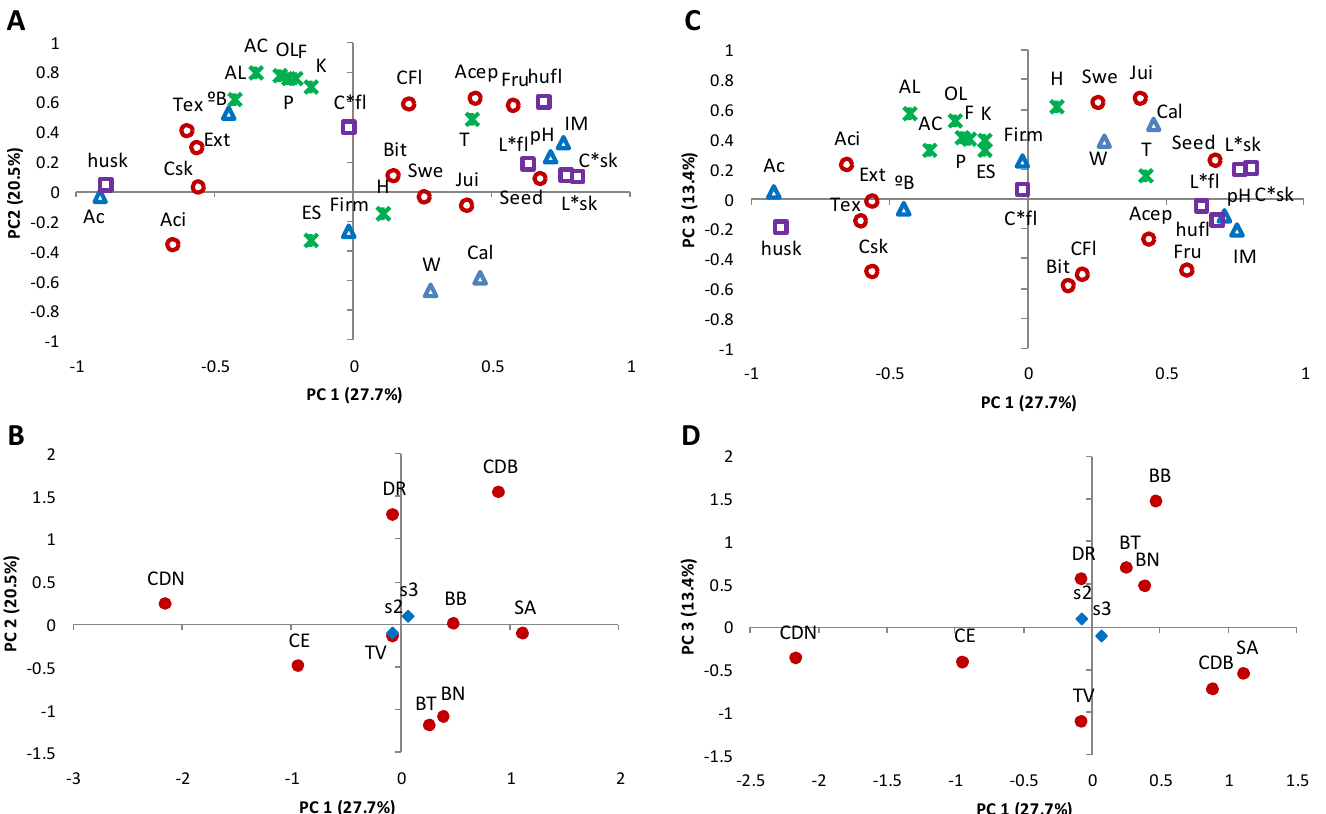
Figure 5. Loading plots ( A and C ) and score plots ( B and D ) after principal component analysis of the varieties, ripening stages, physicochemical, and sensory parameters and in the planes by three first principal components (PC1, PC2, and PC3). Physicochemical parameters ( △ ), weight (W), calibre (C), °Brix (°B), acidity (Ac), pH, maturation index (IM), fi rmness (Firm). Colour parameters ( □ ), skin h* (hsk), C* (C*sk), L* (L*sk); fesh h* (hfl), C* (C*fl), L* (L*fl). Chemical families of ), volatile compounds ( ᚕ ), aldehydes (AL), acids (Ac), alcohols (OL), ketones (K), furans (F), pyrazines (P), hydrocarbons (H), terpenes (T), esters (ES). Sensory parameters ( ○ ), external appearance (Ext), skin colour (Csk), fresh colour (CFl), texture (Tex), sweetness (Swe), bitterness (Bit), juiciness (Jui), fruit flavour ), external appearance (Fru), overall acceptability (Acep). (cid:35)